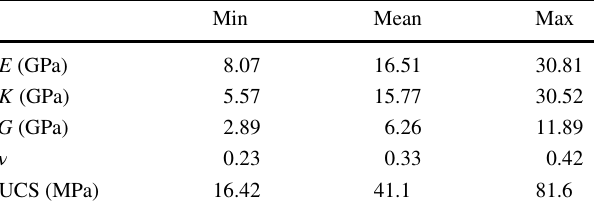
Table 9 The ranges of estimated static elastic moduli (including the bulk modulus, K b and shear modulus G ) and rock strength of Gachsa- ran formation in Kupal field (using MEM results of well